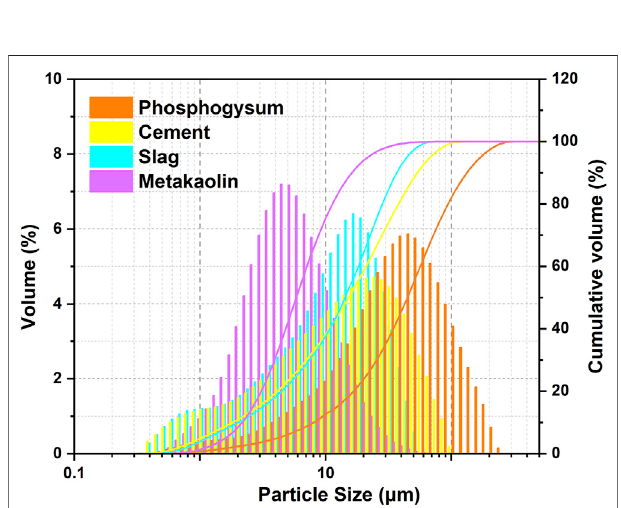
FIGURE 1 | Particle size distribution of raw materials.